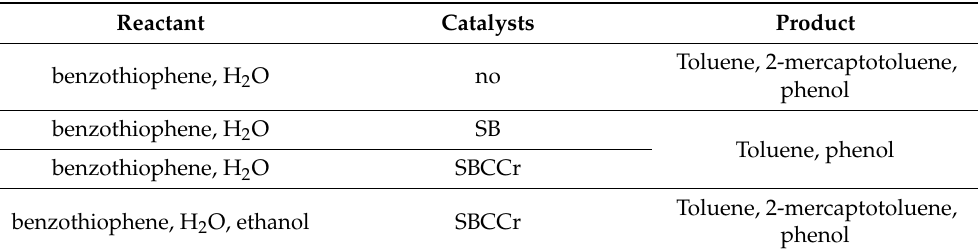
Table 9. New compounds of benzothiophene under different reaction conditions.